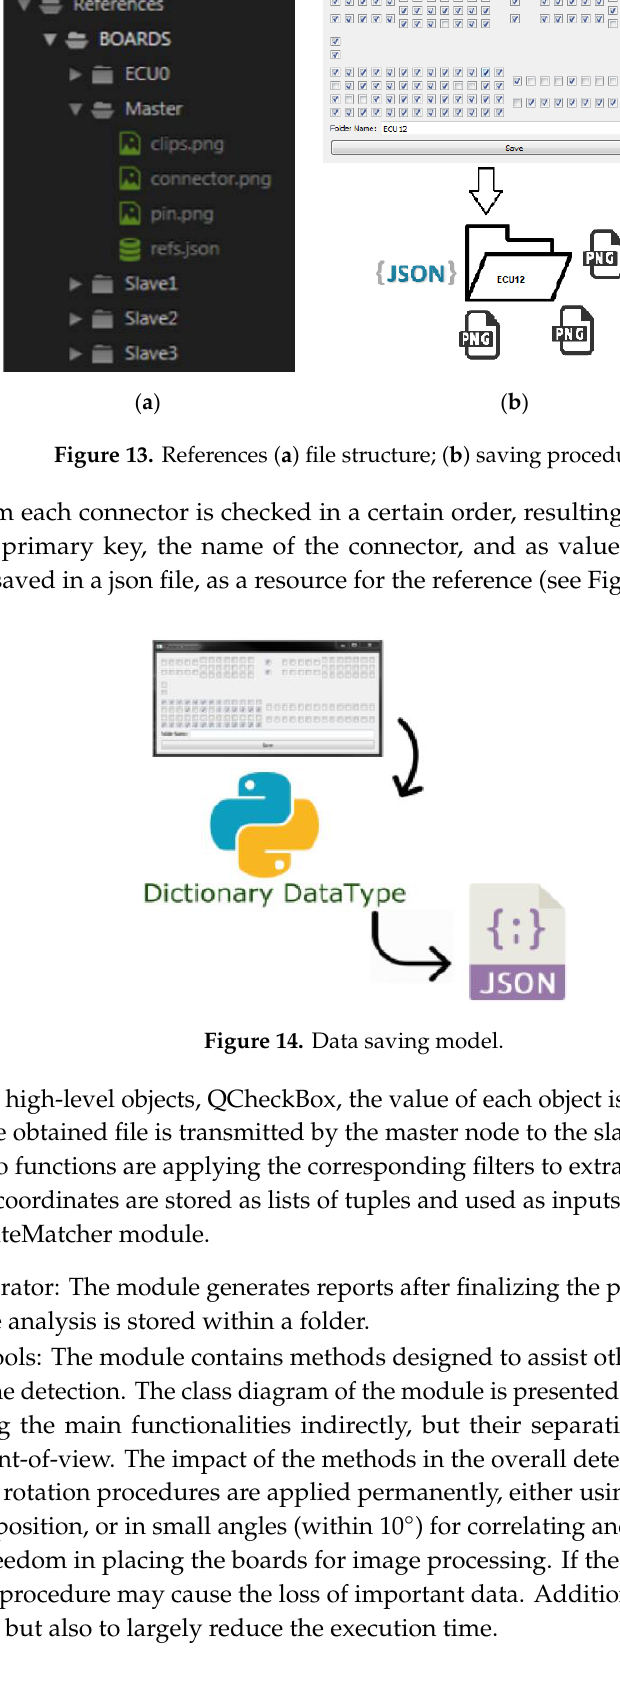
Figure 15. Coordinates conversion process.